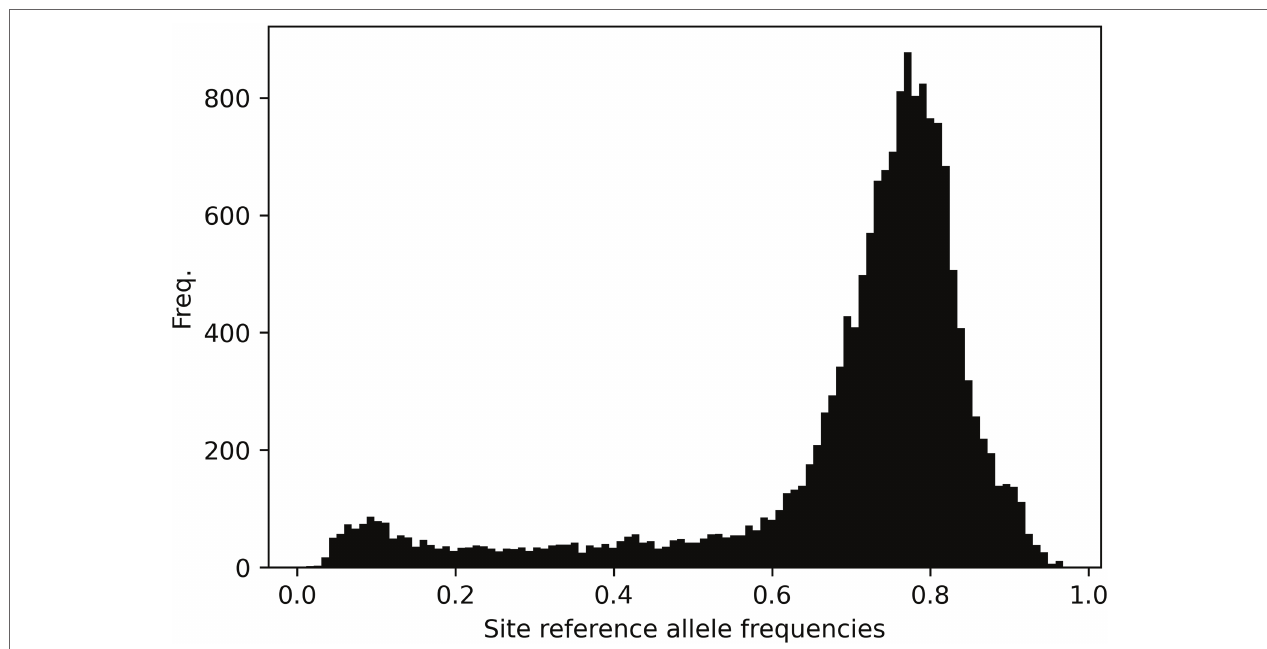
FIGURE 9 | Site-frequency spectrum plot across all 12 rice chromosomes. The data are left-skewed as a result of SNP calling a predominantly indica panel against a japonica reference